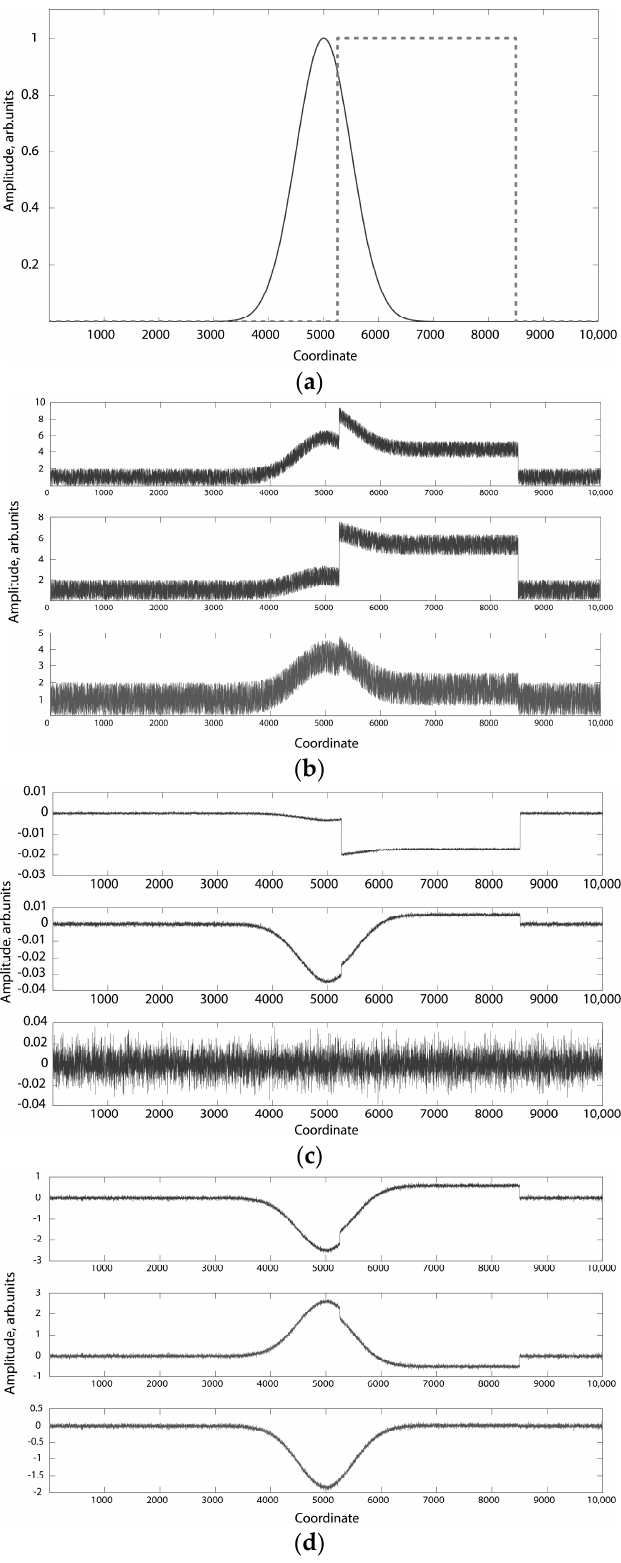
Figure 7. Two 1D archetype functions example: ( a ) the general form of the archetypes; ( b ) examples of noisy superpositions of the archetypes (raw patterns); ( c ) the first three PCs for the set of raw patterns, ( d ) examples of random superpositions of PC1 and PC2.